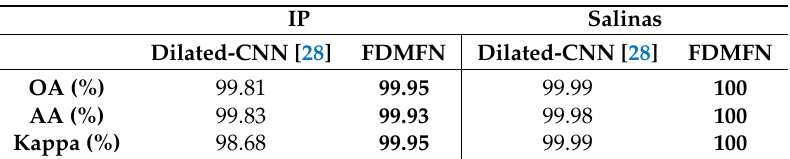
Table 13. Comparison between the proposed FDMFN and the Dilated-CNN [28] method on the IP and Salinas datasets. Note that the best results reported in [28] were used for comparison here. In addition, the best results are highlighted in bold font.